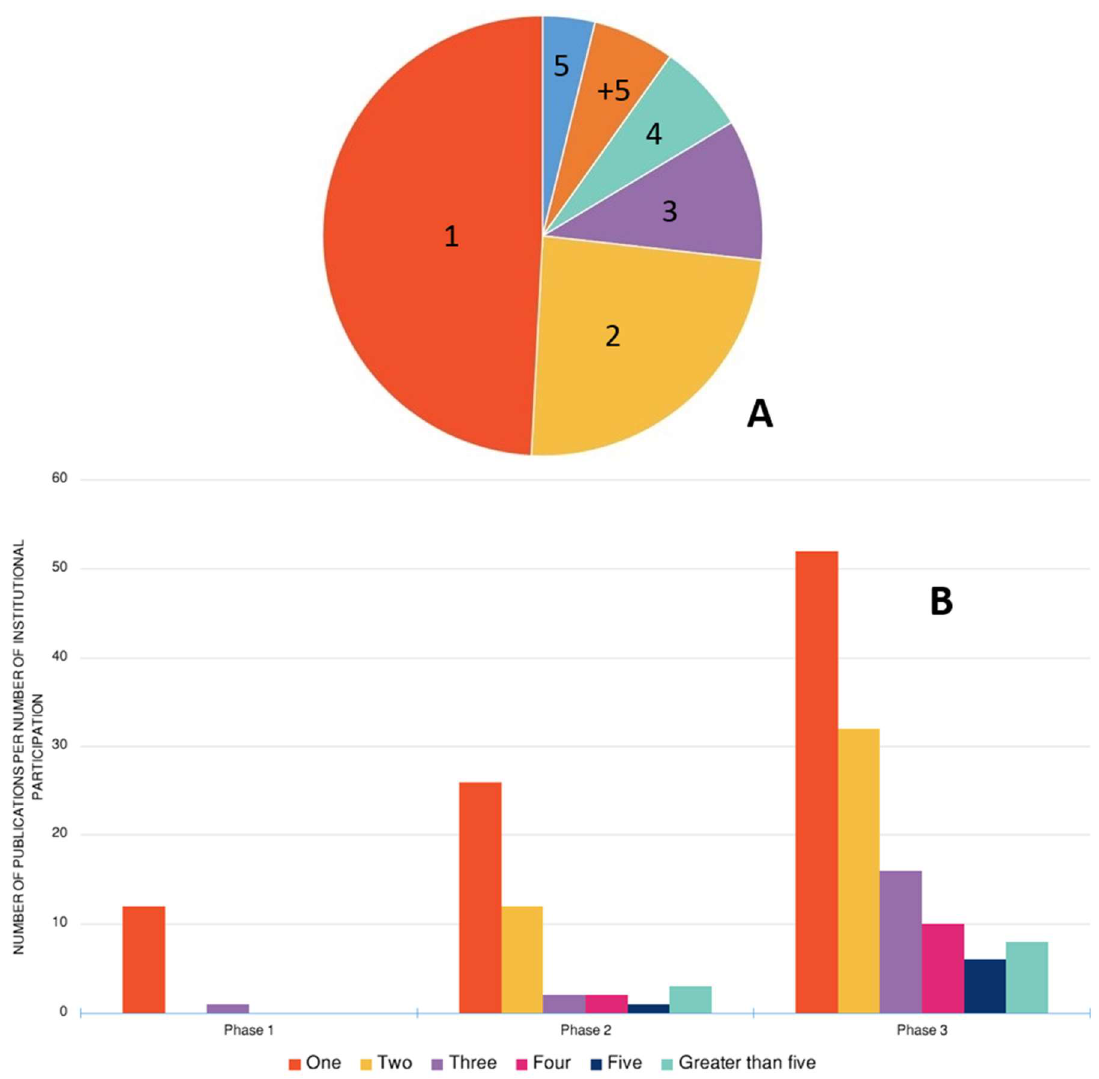
Figure 8. Qualitative and quantitative results of the institutional arrangements parameters. ( A ). Number of institutions in each peer-reviewed publications between 1982 and 2016. ( B ). Number of institutions in each phase over the 35-year period analyzed.